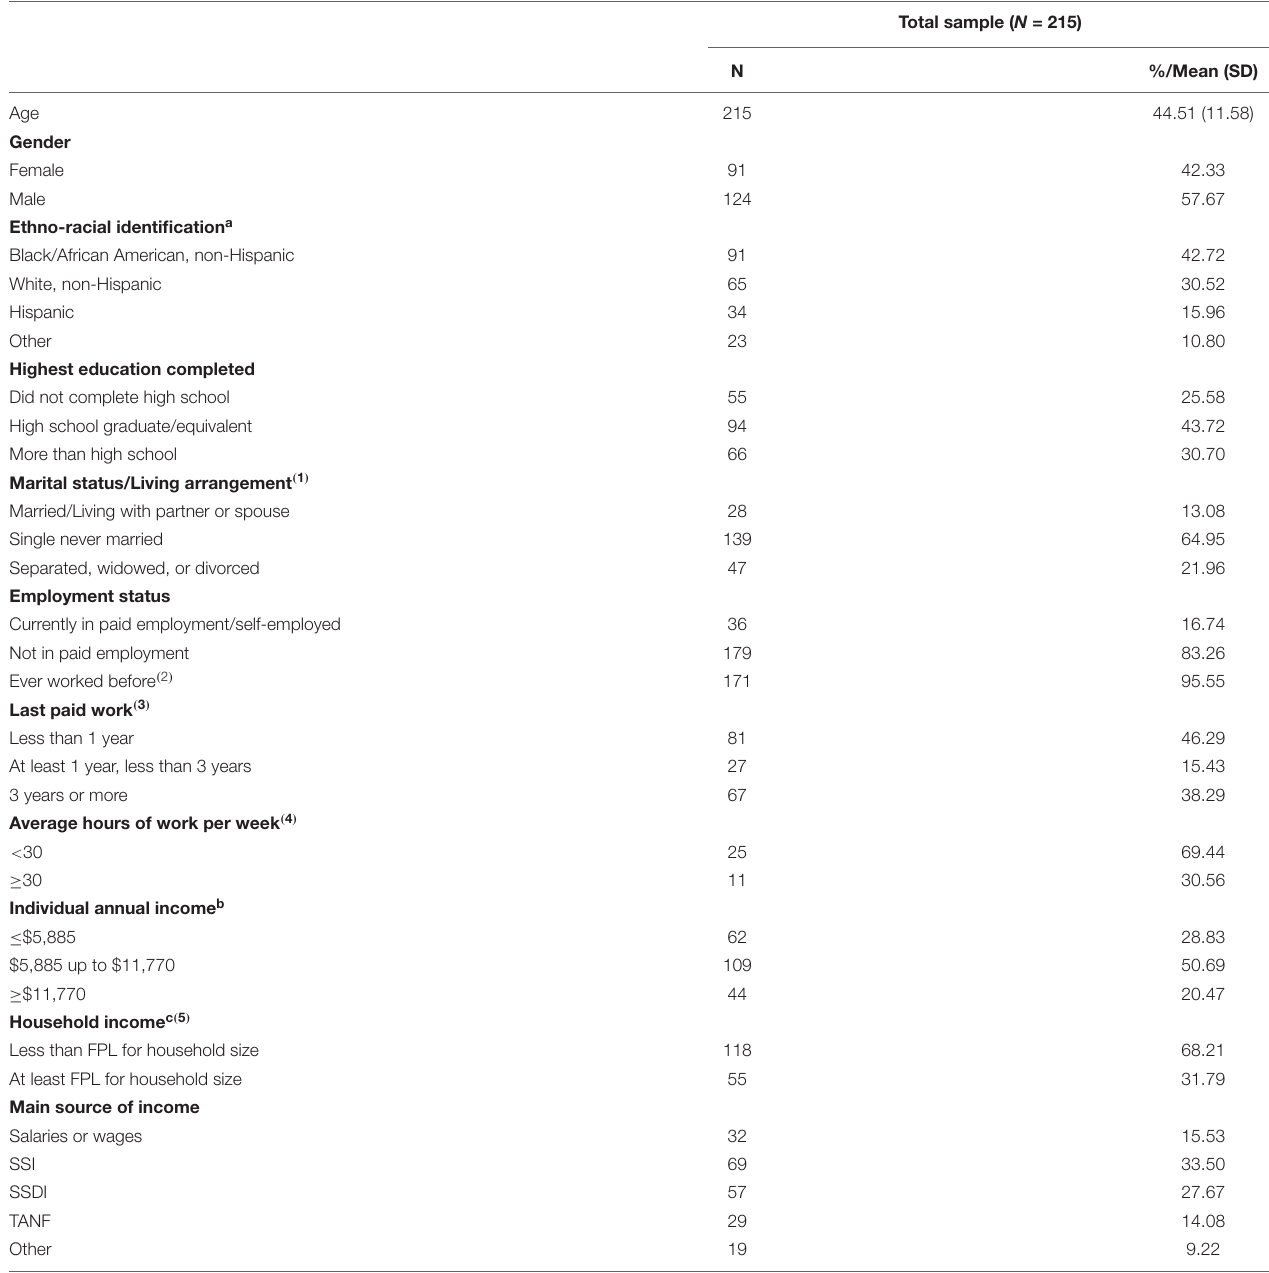
TABLE 1 | Demographic and clinical characteristics of the sample of people with psychiatric diagnoses in employment programs ( N =